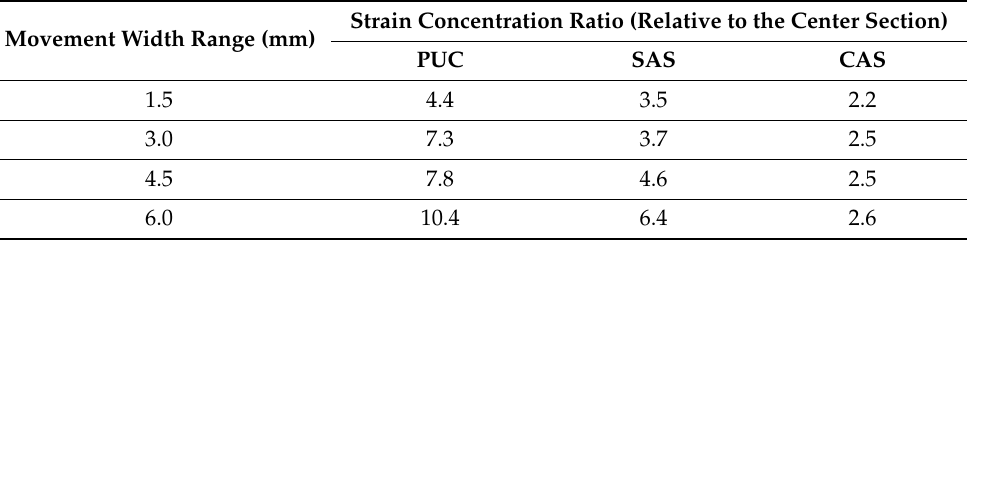
Figure 12. CAS strain difference results (for deriving strain concentration ratio). Table 6. Strain concentration ratio comparison of the waterproofing